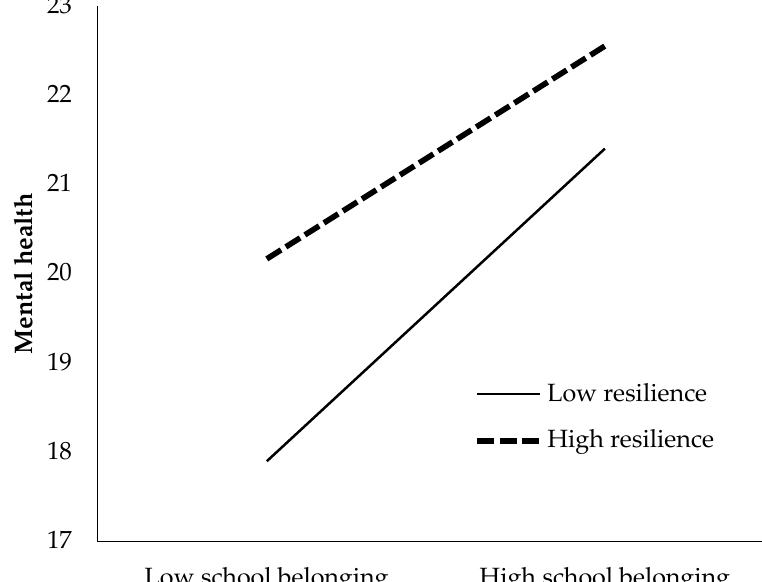
Figure 2. Moderating effect of resilience on the correlation between bullying victimization and mental health.